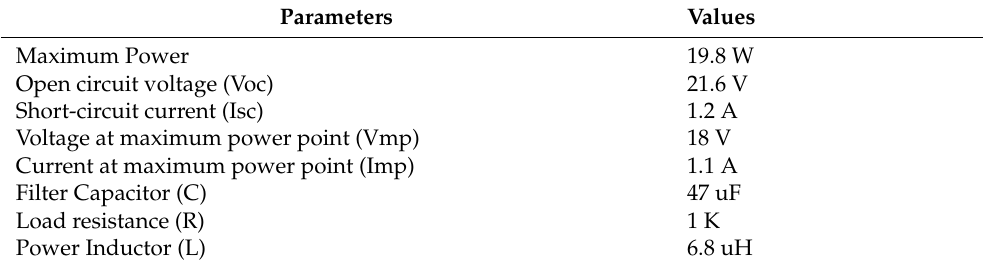
Table 3. PV Module and Circuit Parameters.